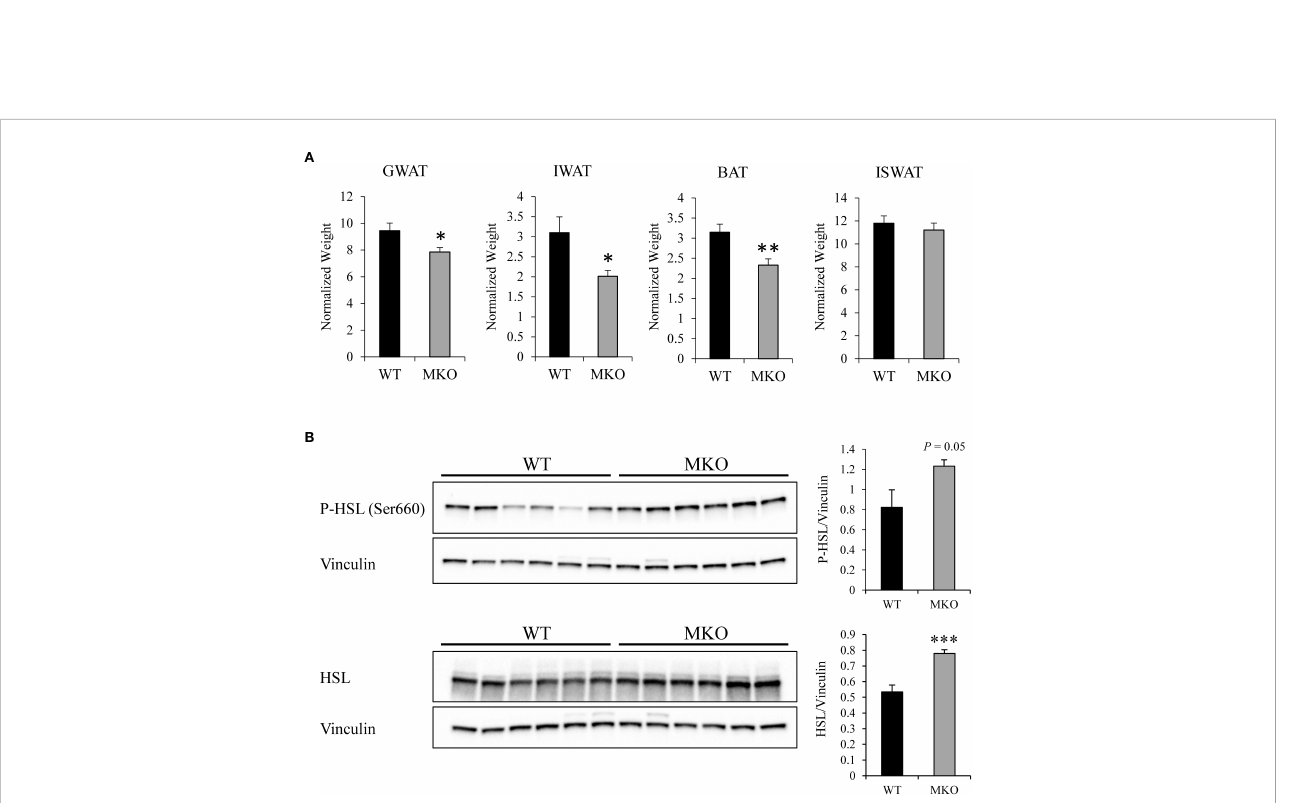
FIGURE 5 Adipose tissue size is reduced and lipolysis is increased in Arid5b MKO mice. (A) Adipose tissue weights were normalized to body weight, and results are expressed as themeans ± SE. (WT, n=13-14; MKO, n=8-11). *, p < 0.05; **, p < 0.01. (B) (right) Western blot analysis was performed for phospho-HSL (Ser660) and total HSL expression in Arid5b WT and MKO GWAT. Vinculin was included as a loading control. (left) Quantitation was performed. ***, p <